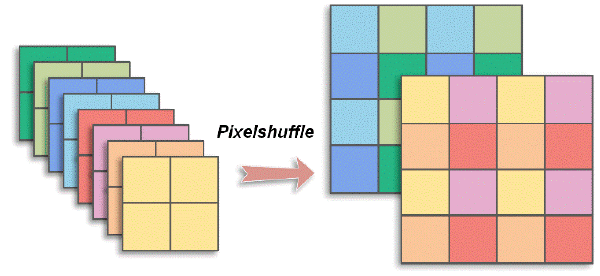
Figure 2. Pixelshuffle